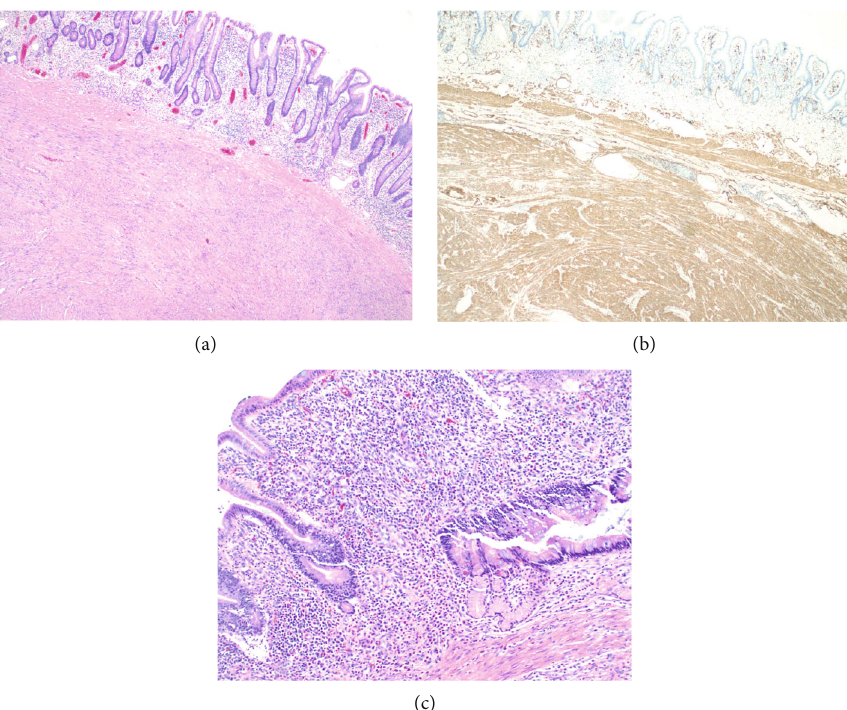
Figure 3: Histology slides from the specimen documenting: (a) small bowel with a submucosal leiomyoma on a hematoxylin and eosin stain magni fi ed 40 × ; (b) smooth muscle actin positivity on immunohistochemistry magni fi ed 40 × ; and (c) moderate-to-severe active chronic enteritis on a hematoxylin and eosin stain magni fi ed 100 ×